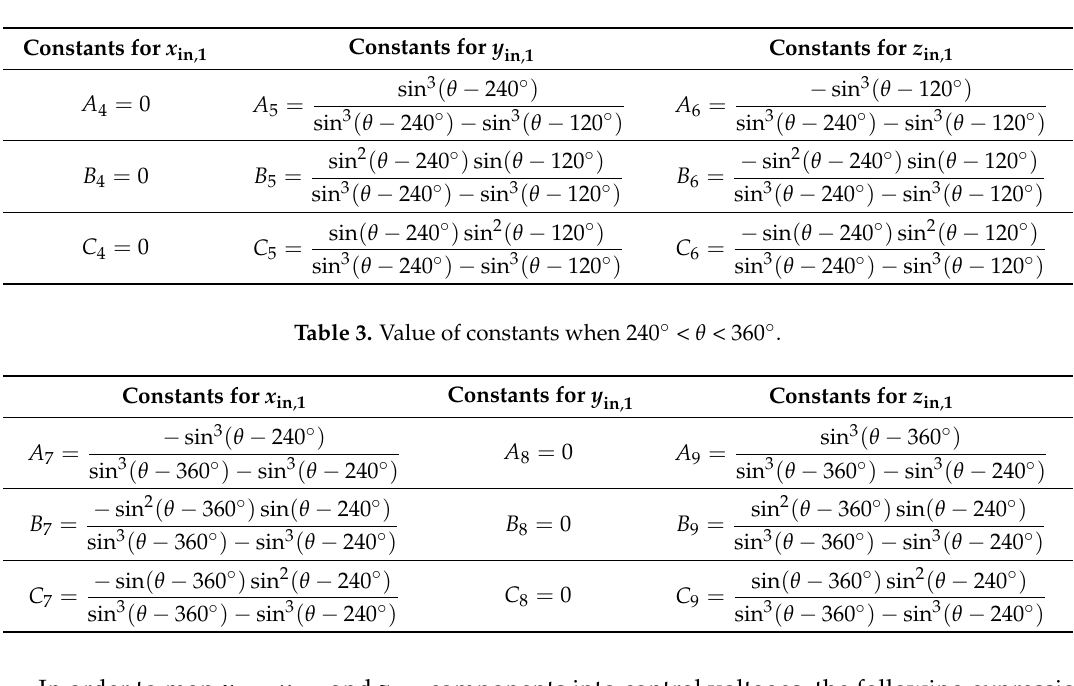
Table 2. Value of constants when 120 ◦ < θ < 240 ◦ .